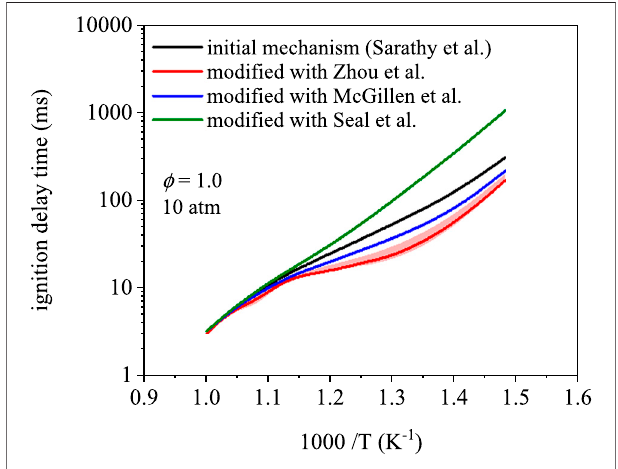
FIGURE 3 | Ignition delay time simulations using the mechanism from Sarathy et al. (Sarathy et al., 2012) and site-speci fi c rate modi fi cations from Zhou et al. (Zhou et al., 2011), Seal et al. (Seal et al., 2013), and McGillen et al. (McGillen et al., 2013). Ignition delay times are nearly identical at 1000 K; however, ignition delay times differ towards lower temperature, where peroxy radical chemistry dominates, up to a factor of 6.3 at 675